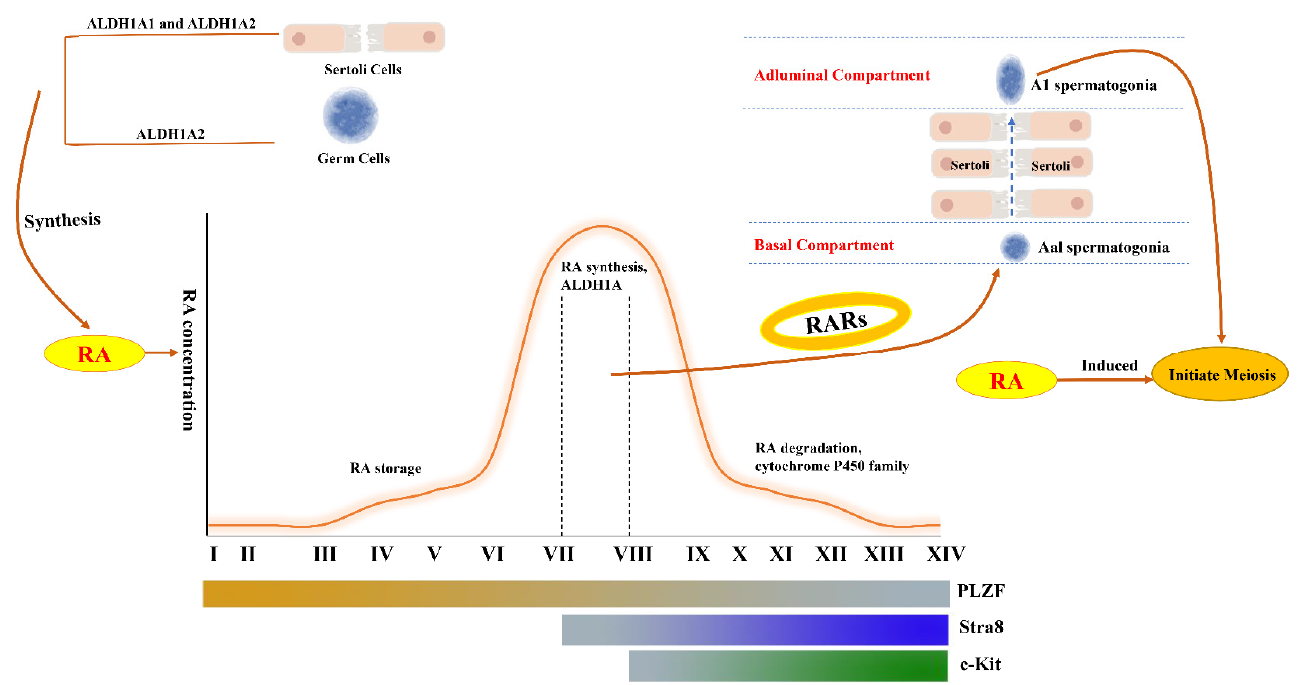
Figure 3. The role of retinoic acid pulse in the cycle of the seminiferous epithelium. The production of RA is mainly from Sertoli cells and germ cells in the testis after birth, and this process is mainly catalyzed by ALDH1A1 and ALDH1A2. The concentration of RA is stored in the seminiferous epithelium during stages I to VI, and rises to a peak during stages VII–VIII, and is then gradually degraded by CYP26 enzymes. The transition of Aal spermatogonia to A1 spermatogonia also occurs during stages VII–VIII. The Aal-A1 transition and meiosis process could be induced by RA administration. RA binds to RAR and can activate some downstream genes. The expression patterns of PLZF, Stra8, and c-Kit are depicted with gradual change lines.